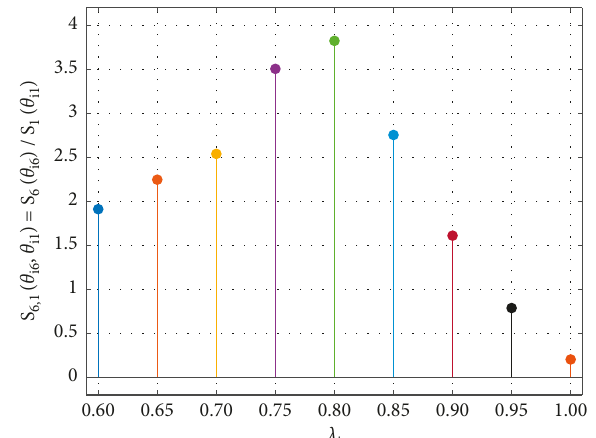
Figure 9: Relative performance index values S value of λ i ( i � 1, ... , 9), which represent the ratio between model performance indices obtained with method # 6 and #